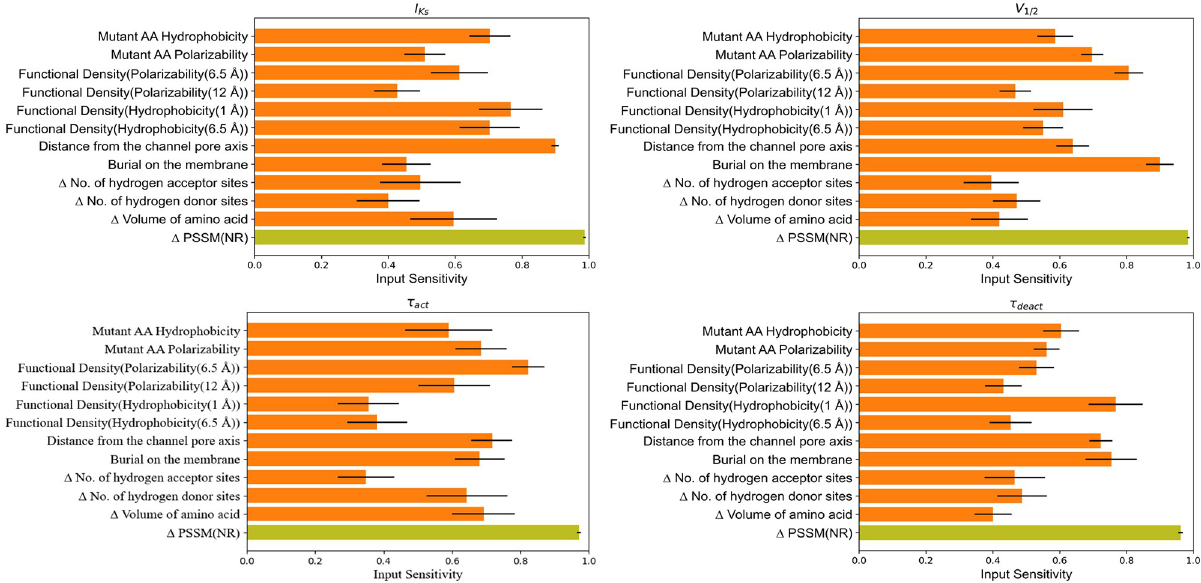
Fig 4. Average input sensitivities for ANN model trained with combined evolutionary and biophysical features. Biophysical features are shown in orange and evolutionary features in olive color.